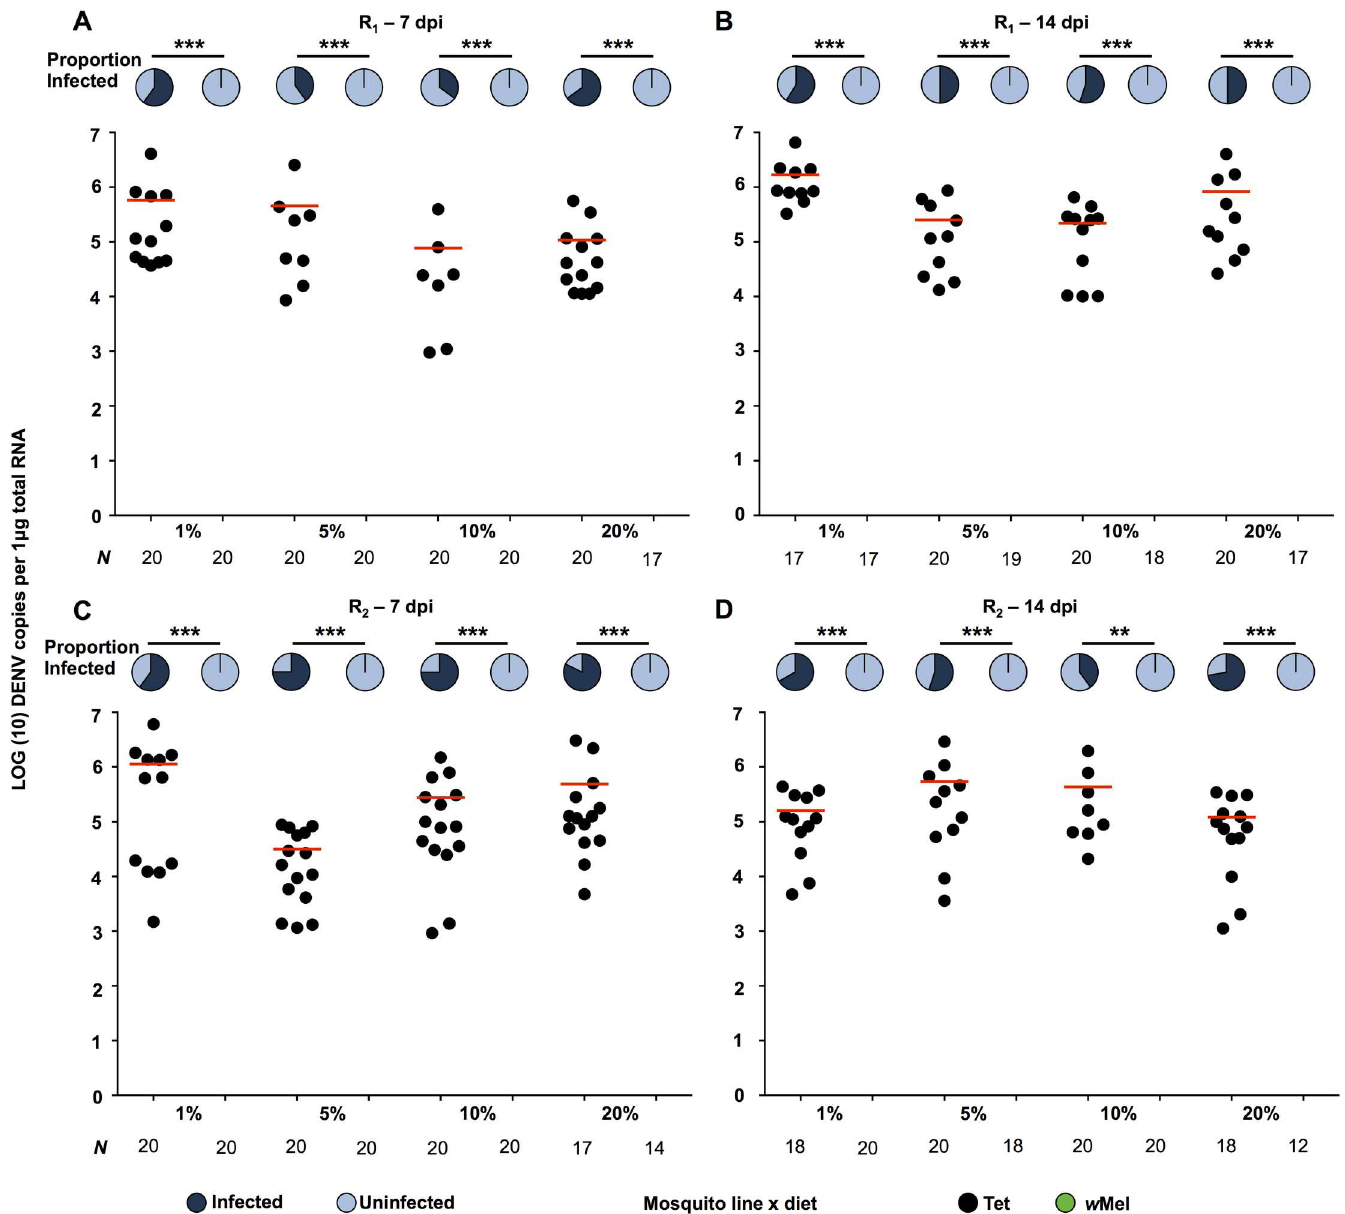
Fig 1. Interferenceagainst DENV-3 in w Mel-infected Ae . aegypti fed on different carbohydrate regimes. DENV-3 prevalence and intensity data for w Mel (+ Wolb ) and Tet (- Wolb )mosquitoesfed on one of four carbohydratediets after experimental oral infection(R 1 — A - 7dpi, B - 14dpi; R 2 — C - 7dpi, D - 14dpi), as determined by RT-qPCR quantification using a DENV-specific TaqMan probe. Pie charts represent prevalence of infection(dark blue— proportioninfected, light blue—proportion uninfected), and dot plots represent viral load in infected mosquitoes. Horizontallines in each treatment